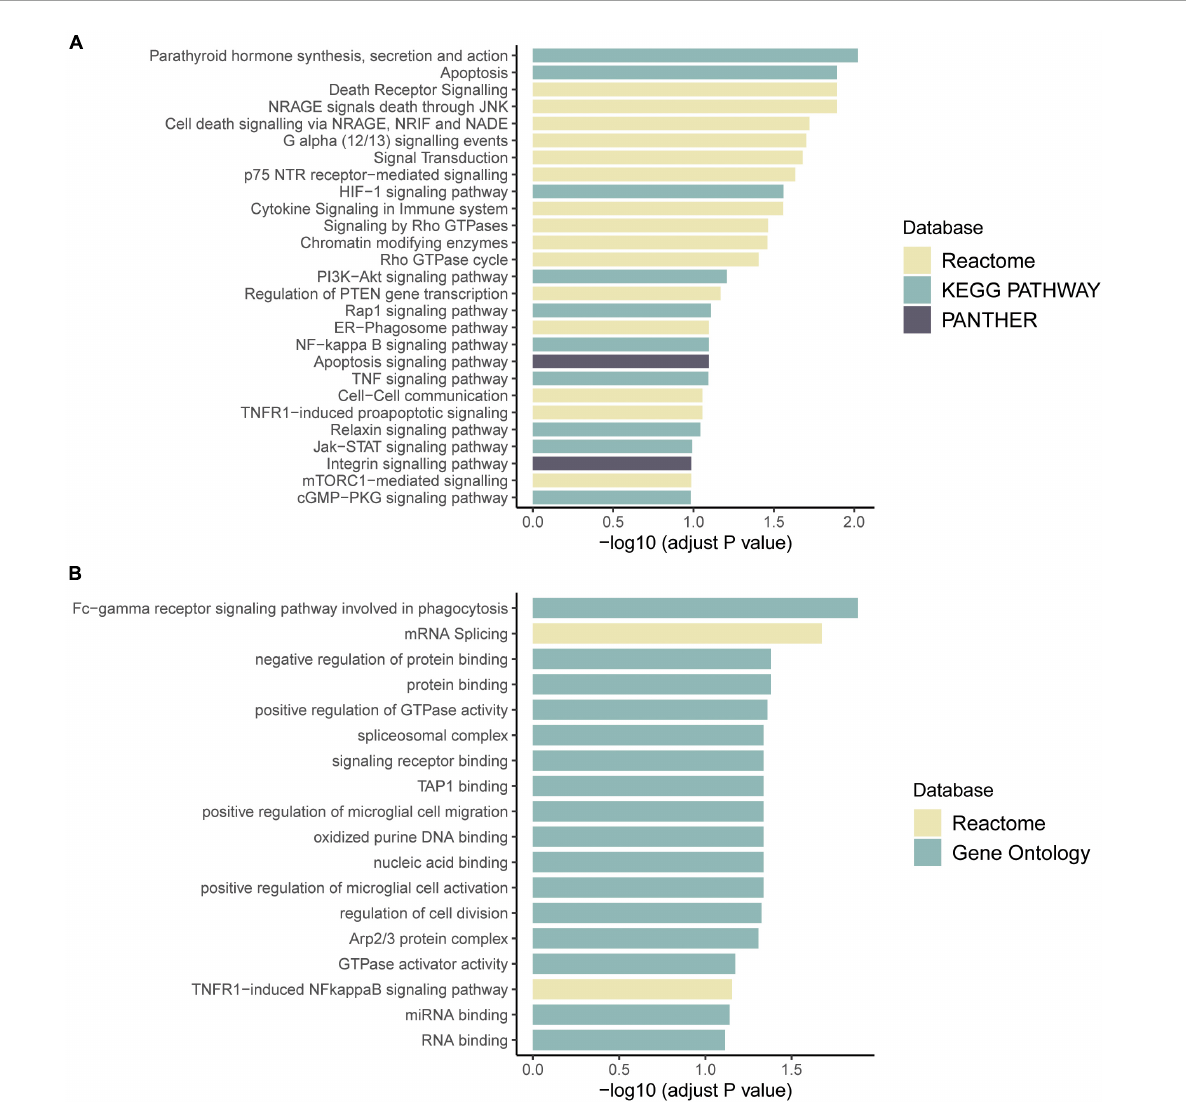
FIGURE5 Pathway enrichment results of genes with aberrant expression (A) and with aberrant splicing (B) . Colors represent pathway items from different databases. The X-axis shows the log-transformed adjusted p -value. Pathways with an adjusted p < 0.1 were selected as significant pathways and